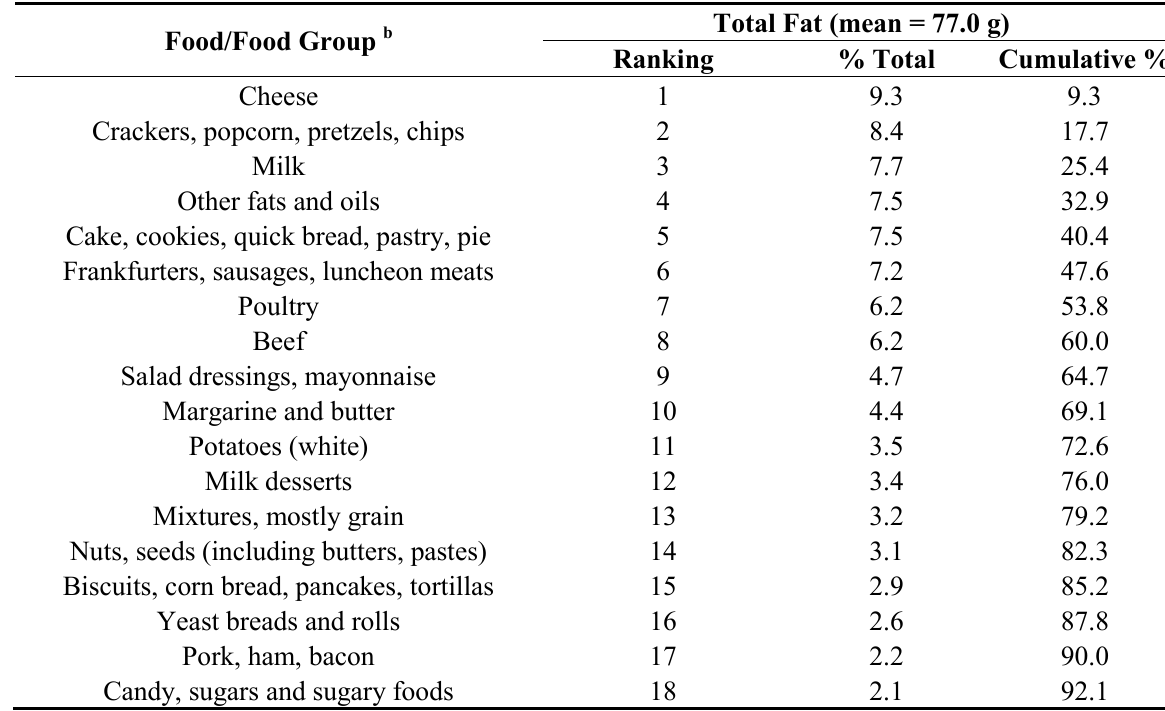
Table 7. Food/Food group sources of total fat among US children aged 2–18 years (from NHANES 2003–2006) a .